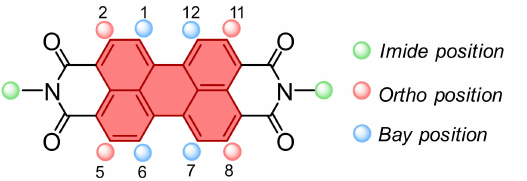
Figure 1. Strategies for functionalization of perylenediimide (PDI)